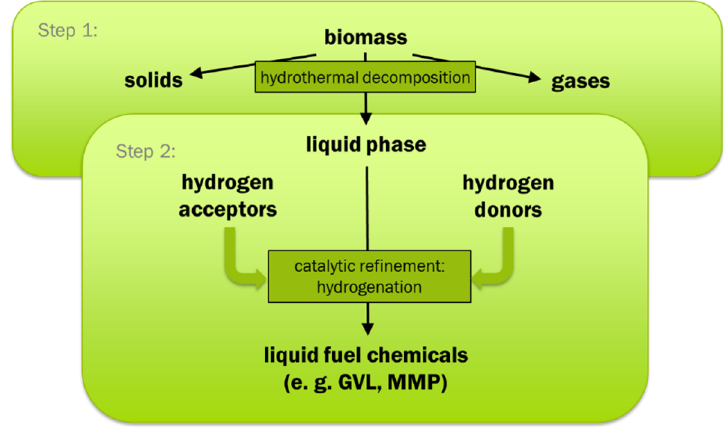
Figure 1. Schematic diagram of the approach.